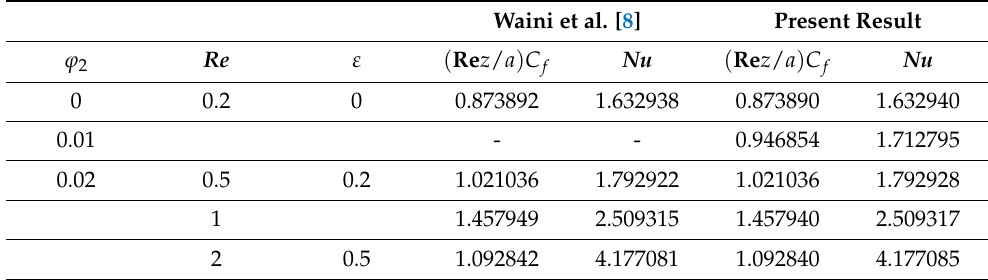
Table 4. Comparison values of